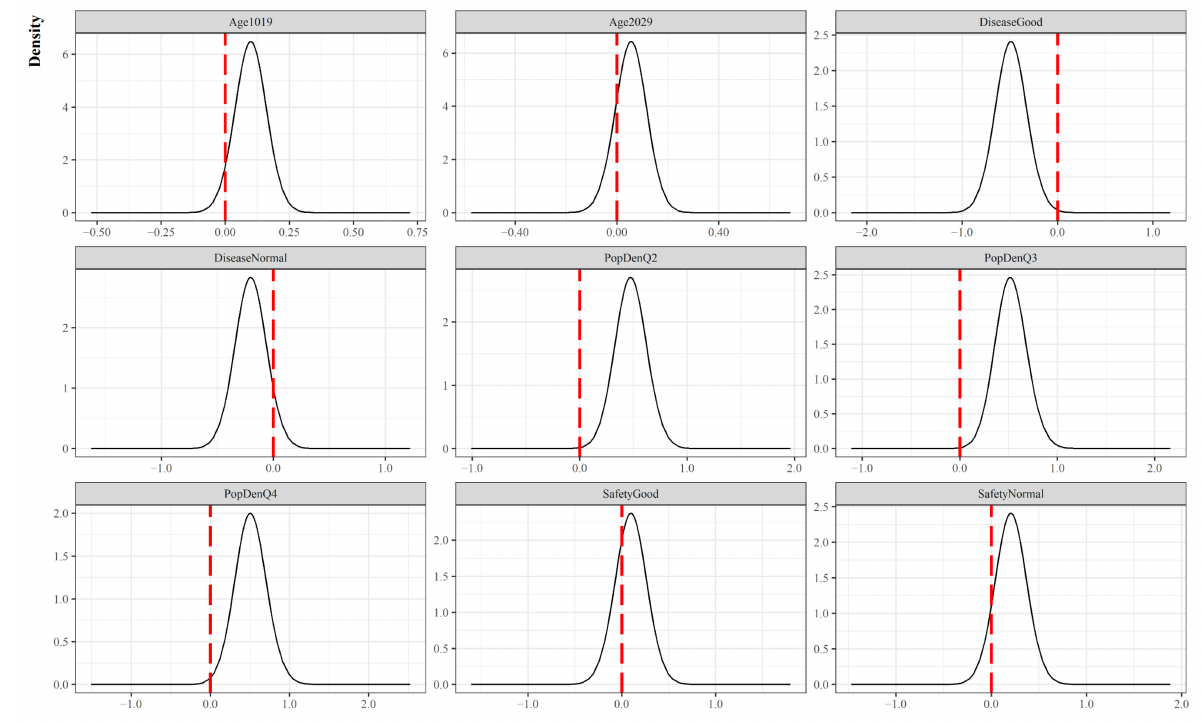
Figure 4. Marginal posterior distribution of covariates (Fixed